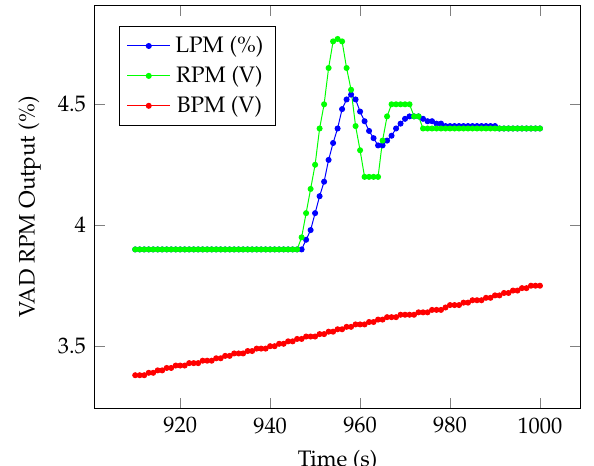
Figure 11. Simulation results considering the proposed architecture of the VAD supervisory and control system. The heart beating increased and decreased (red curve). The speed control set point changed three times up and three times down to adjust the motor peed with the pump rotation (the blue curve).